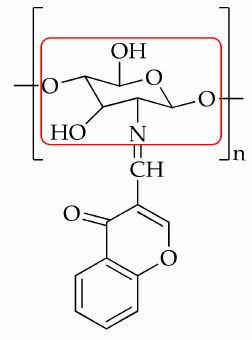
Figure 2. Polymeric structure of chitosan